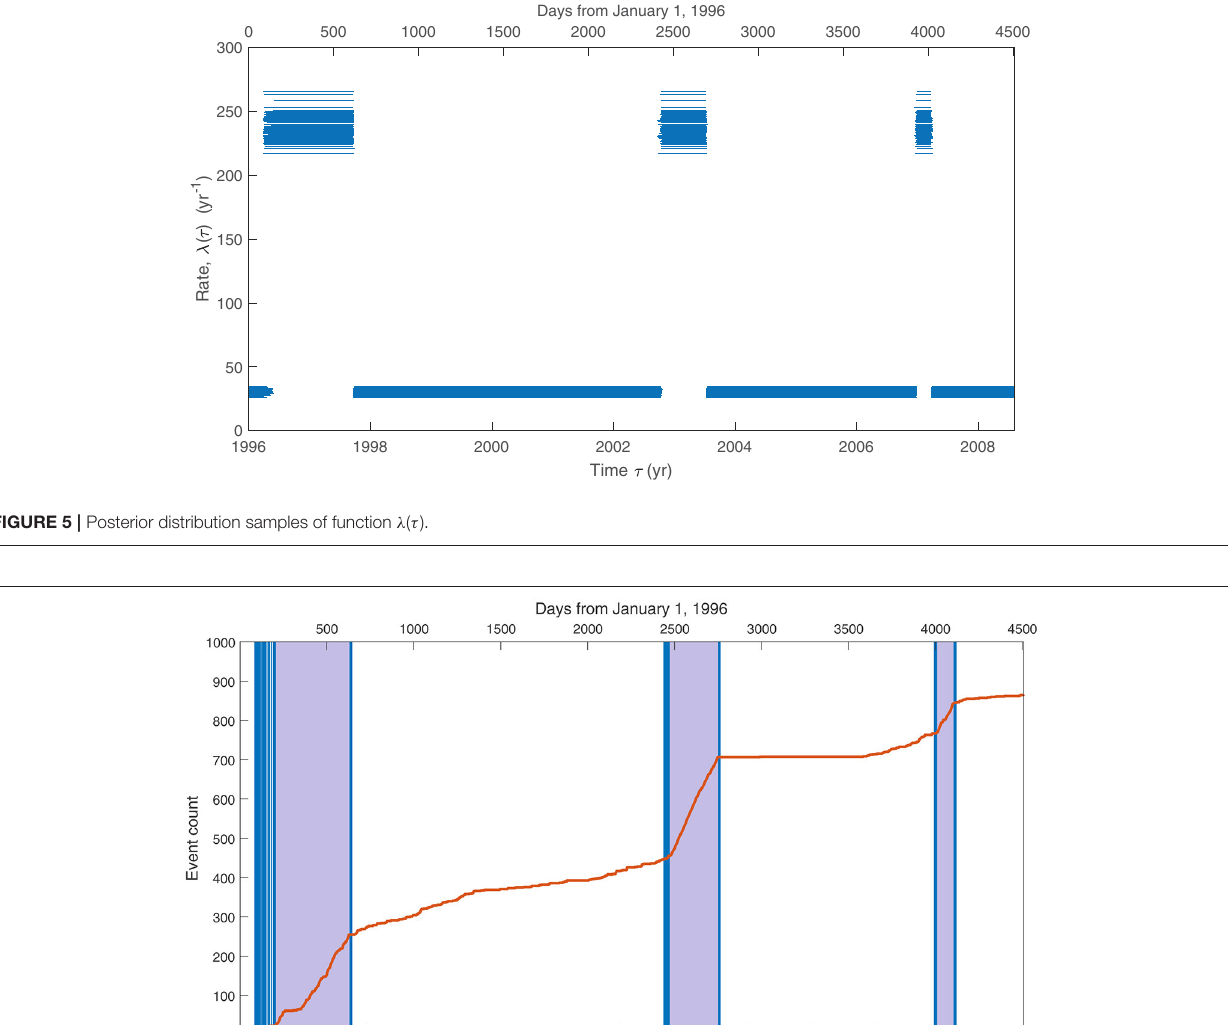
FIGURE 6 | Cumulative event counts as red curve, with posterior high-activity periods indicated by slate blue shading and transition times between activity levels indicated by dark blue lines. Width of dark blue segments indicates posterior uncertainty about transition times. Line slopes correspond to heights in Figure 5 .